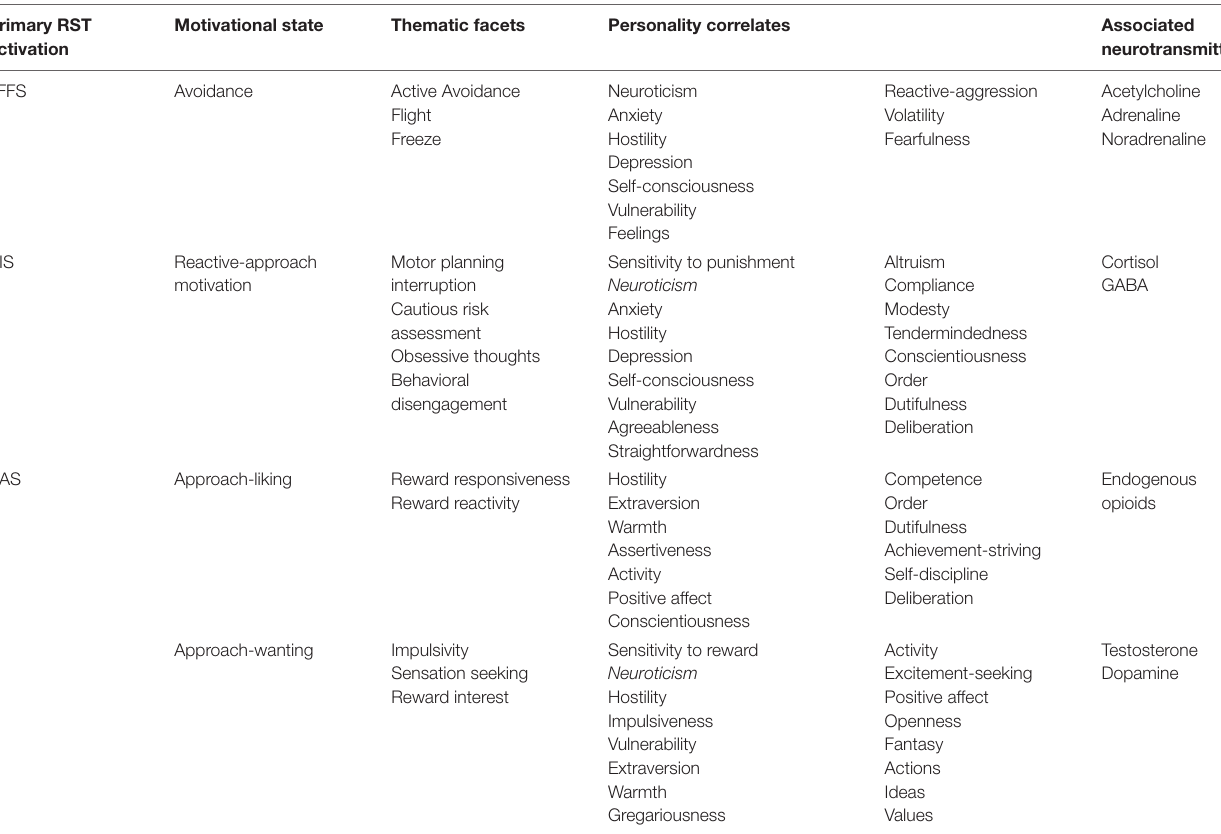
TABLE 1 | Reinforcement Sensitivity Theory (RST) pathways and associated personality traits and neurotransmitters. Primary RST